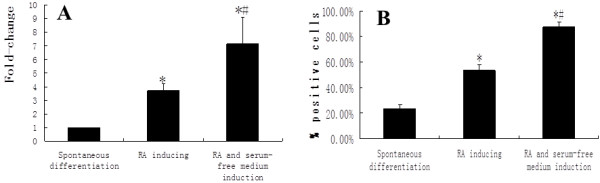
The expression of Nestin during the induction process among the three groups. The quantity of mRNA of Nestin in RA plus serum-free medium group was the highest among the three groups (A). During the induction process, Nestin-positive cell rate was the highest in RA plus serum-free-medium group (B) (*compared with the spontaneous-differentiation group, P < 0.05; #compared with the RA-induction group, P < 0.05).